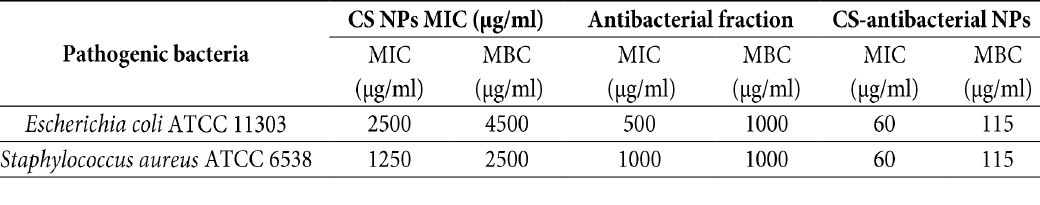
Table 3. Antibacterial assay (MIC and MBC) of CS NPs, antibacterial fraction and antibacterial-loaded Cs